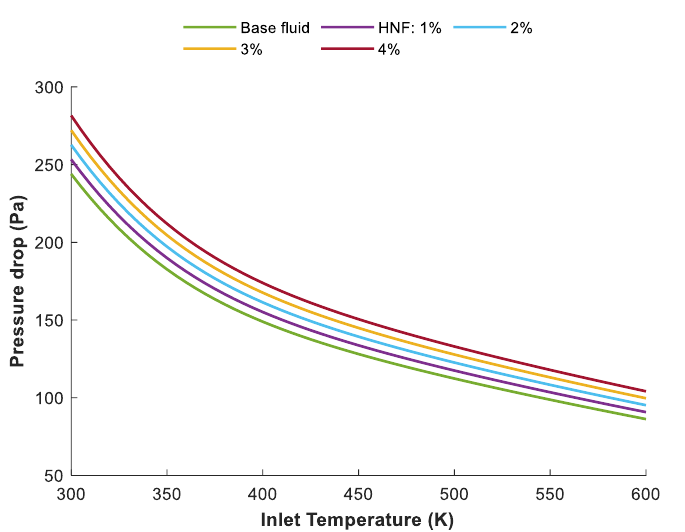
Figure 8. Enhancement ( A ) heat transfer coefficient and ( B ) dimensionless Nusselt number versus inlet temperatures.